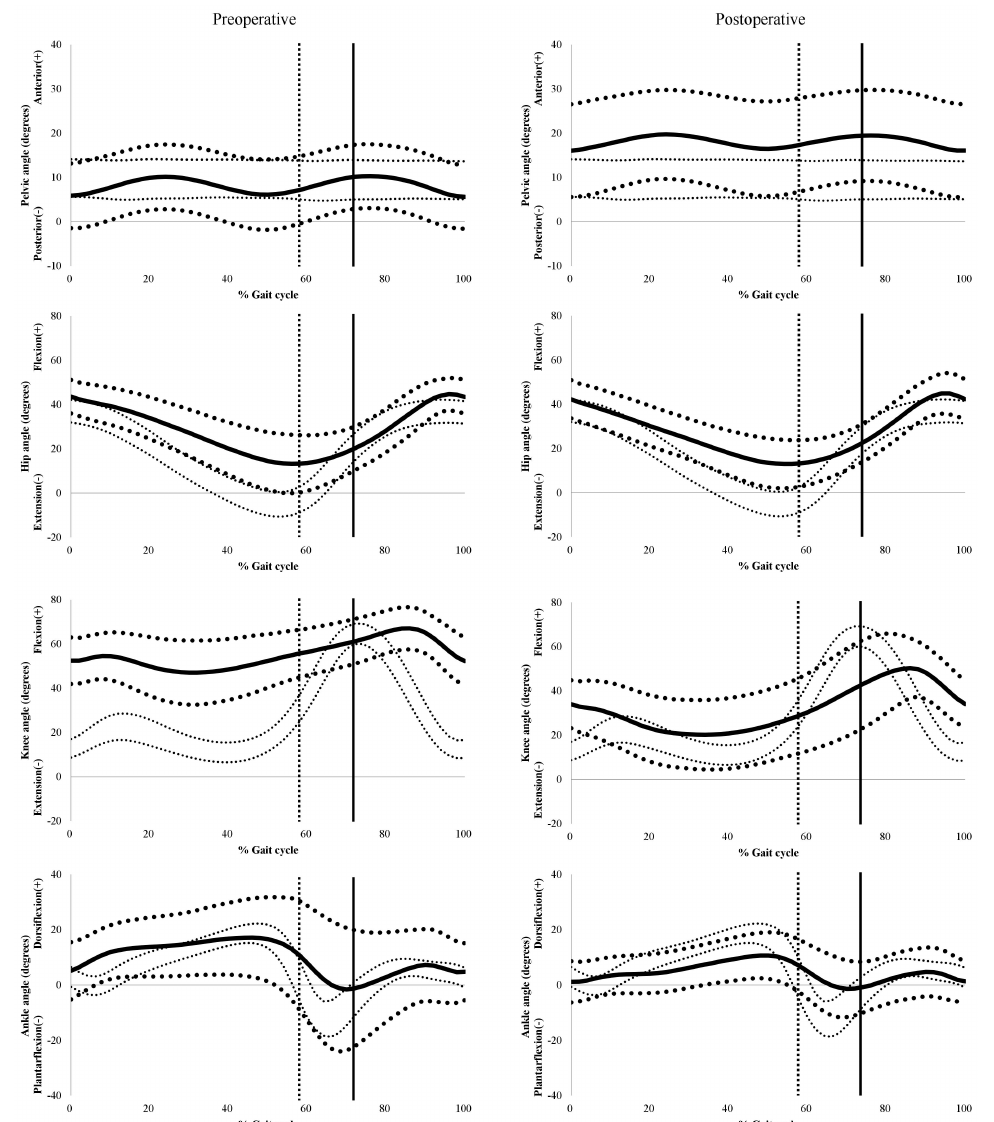
Figure 3. Preoperative and final follow-up sagittal plane kinematic graphs for the whole cohort. Bold solid lines indicate average values. Bold dotted lines represent one standard deviation. Fine dotted lines indicate the normal range.